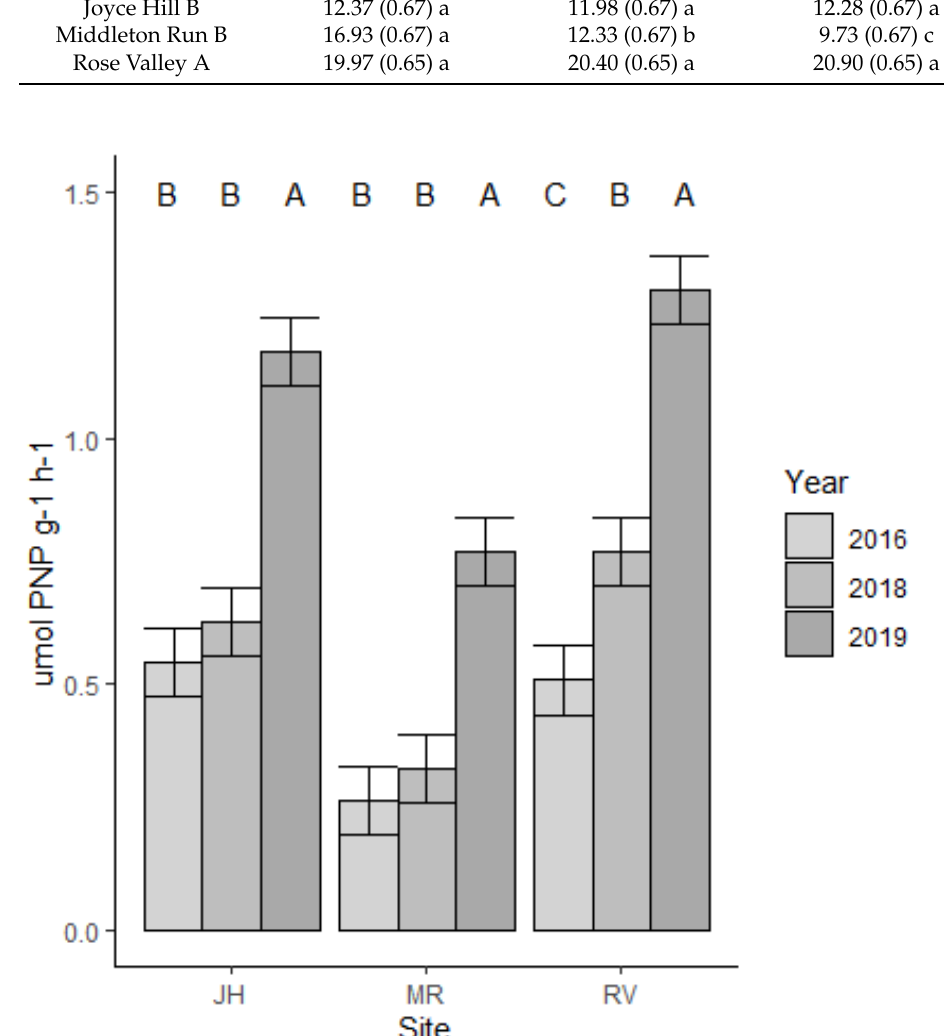
Figure 6. Beta-Glucosidase activities at Middleton Run, Joyce Hill, and Rose Valley. Two of three base cations and phosphorus (P ( F 2, 36 = 3.91, p = 0.029), Mg ( F 2,36 =